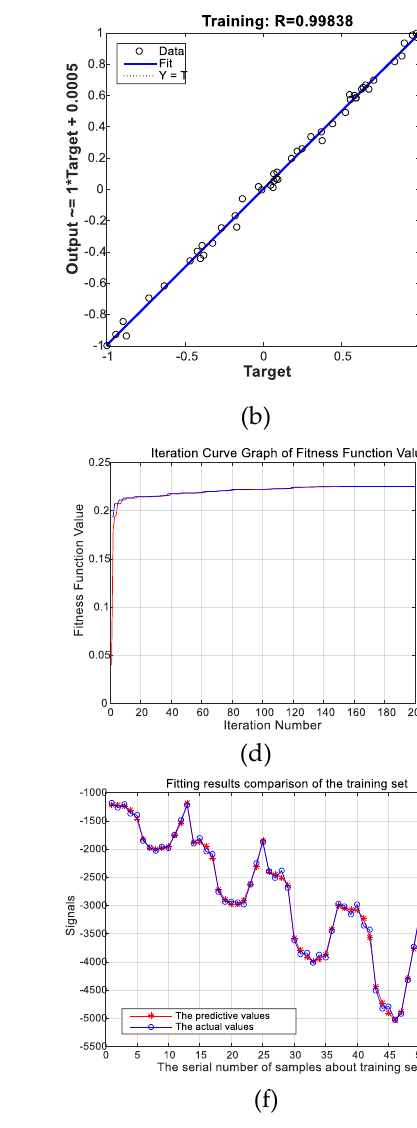
Figure 6. ( a ) Regression curve of the BPNN model error; ( b ) regression curve of the GA-BPNN model error; ( c ) GA iteration curve graph of mean square error; ( d ) GA iteration curve graph of fitness function value. ( e ) The fitting results comparison of the training set about BPNN; ( f ) The fitting results comparison of the training set about GA-BPNN.